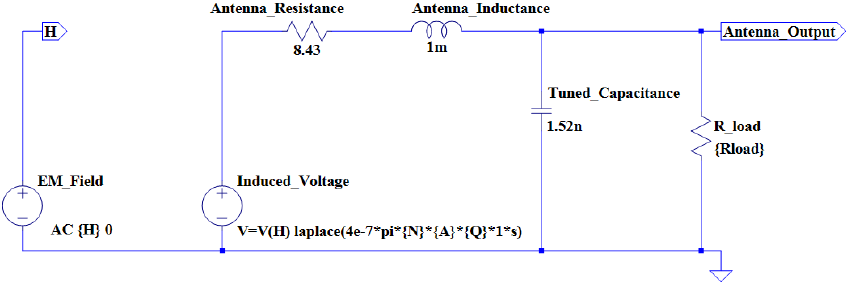
Figure 4. The square antenna simulation model.